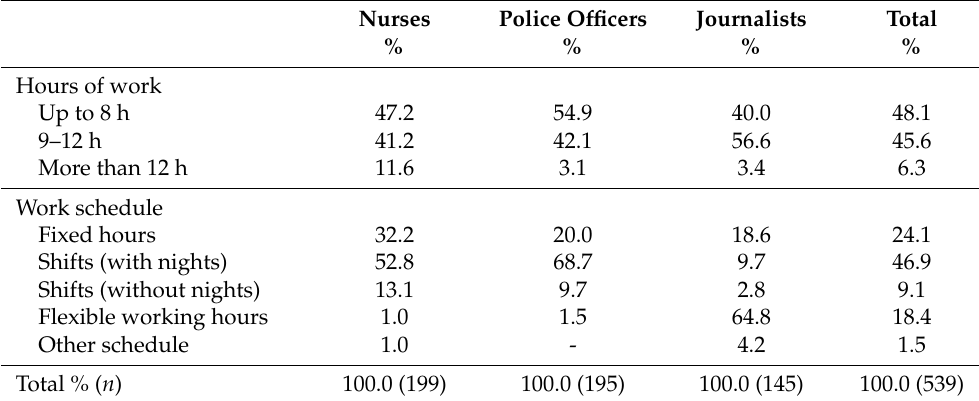
Table 1. Number of hours of work per day and work